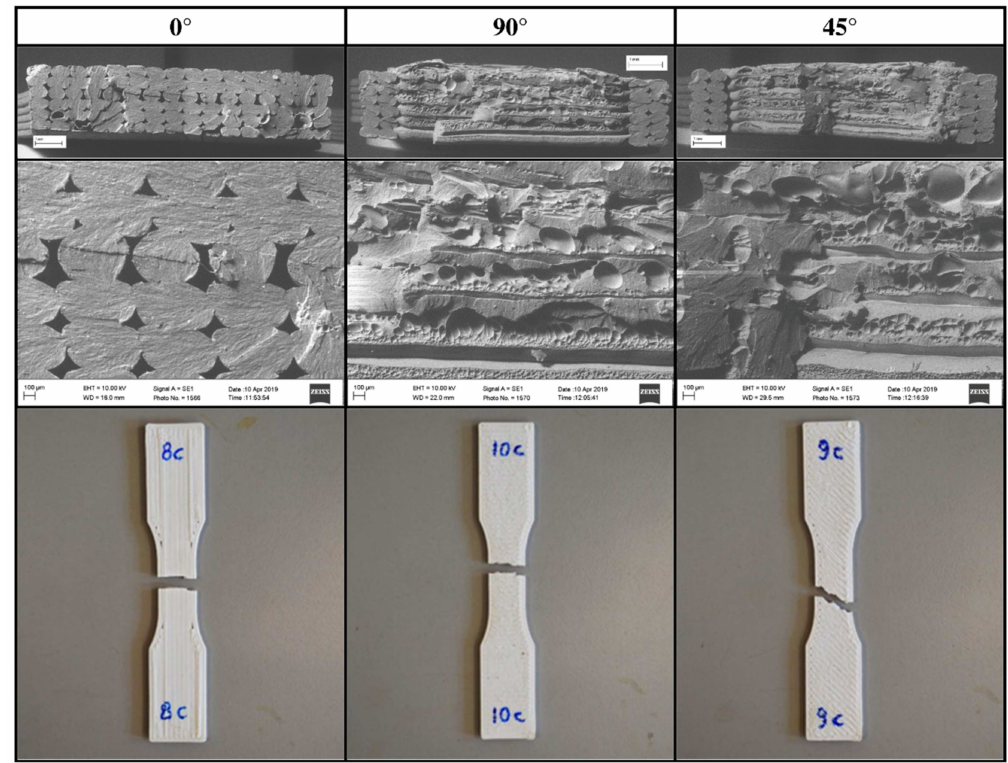
Figure 18. Fracture section for the multilayer